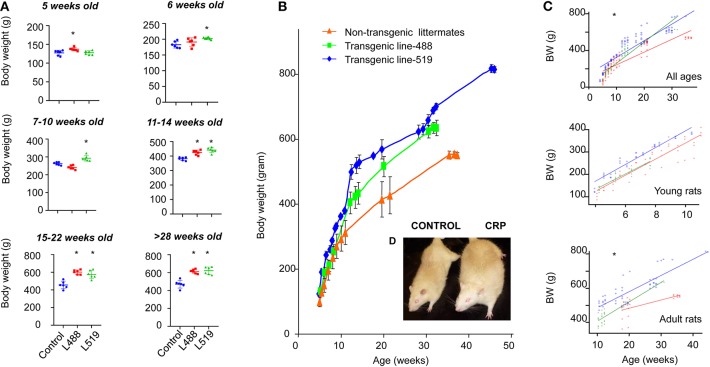
Adult-onset obesity observed in the CRP transgenic rats. (A) Body weight is shown by mean and SD at different ages. The p-values of student t-test are shown above the bar. Male rats of male human CRP transgenic line 519 (n = 6), line 488 (n = 6) and their non-transgenic littermates (n = 6) were included in this experiment (*p < 0.05). (B) The growth curve of the human CRP transgenic rats and their non-transgenic littermates. Means and standard deviations (SD) are showed at each time point for line-519 (male, n = 13), line-488 (male, n = 8) and the non-transgenic group (male, n = 9). Among the rats younger than 10-week old, body weight of transgenic rats is not substantially higher than the non-transgenic littermates; when rats are older than 11 weeks old, the body weight of transgenic rats start to be higher than the control rats. According to the results obtained from the univariate linear regression analysis of scatter plot of body weight using age as explanatory variable, growth rates are similar between transgenic rats and control rats before 10 weeks old [42.2 (transgenic line 488), 38.5 (transgenic line 519), and 37.6 (control group)]; however, when the rats are older than 11-weeks old, the growth rates of transgenic rats are about 2-fold higher than the control rats [11.8 (transgenic line 488), 9.5 (transgenic line 519), and 5.0 (the control rats)]. These results indicated that it is adult-onset obesity developed in these rats. (C) Univariate linear regression on the scatter plot of body weight using age as explanatory variable, young rats, ≤10 weeks old, adult rats, ≥11 weeks old, *p < 0.001; (D) Gross appearance of a male 1-year-old CRP transgenic rats and a male 1-year-old control rat.